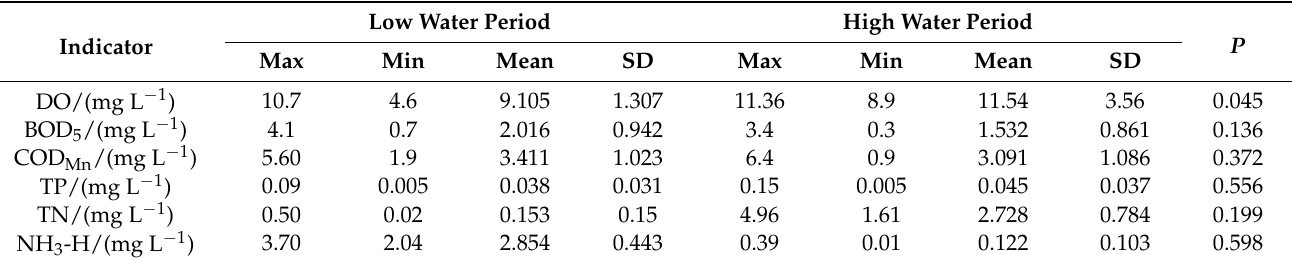
Table 3. Statistical description of the Beizamu section.